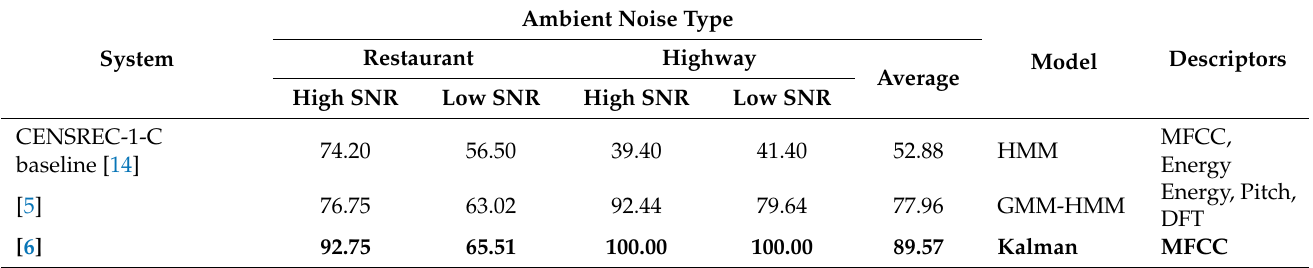
Table 3. VAD utterance-level top test accuracy [%] vs. model type–CENSREC-1-C subset